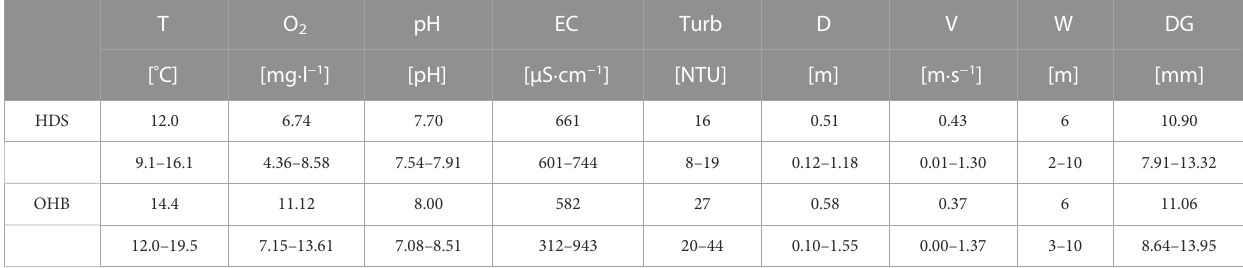
TABLE1Importantphysico-chemicalvariablesoftheLängenmühlbach(HDS)andOttheinrichbach(OHB)duringspringandsummer.T,temperature;O 2 ,dissolved oxygen [mg · L − 1 ]; pH, pH-value; EC, electric conductance [µS · cm − 1 ]; Turb H, turbidity [NTU]; D, water depth [m]; V, riverbed velocity [m · s − 1 ]; W, river width [m]; DG, mean particle diameter of spawning ground substrate [mm].